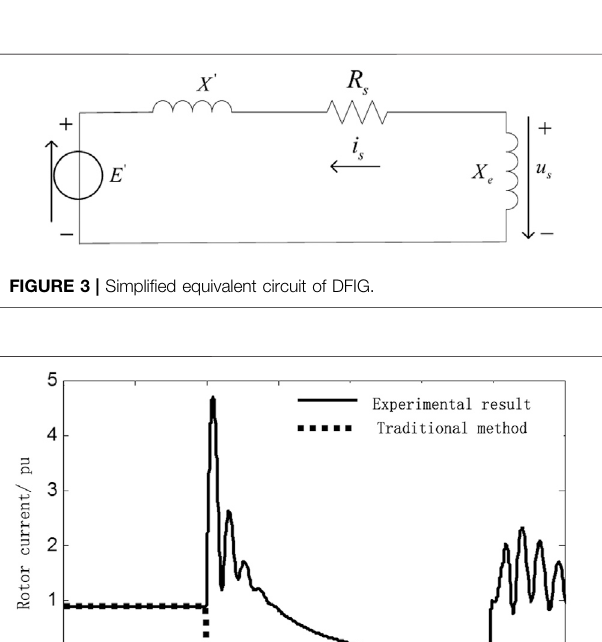
FIGURE 2 | Fault equivalent circuit of DFIG wind power generator.